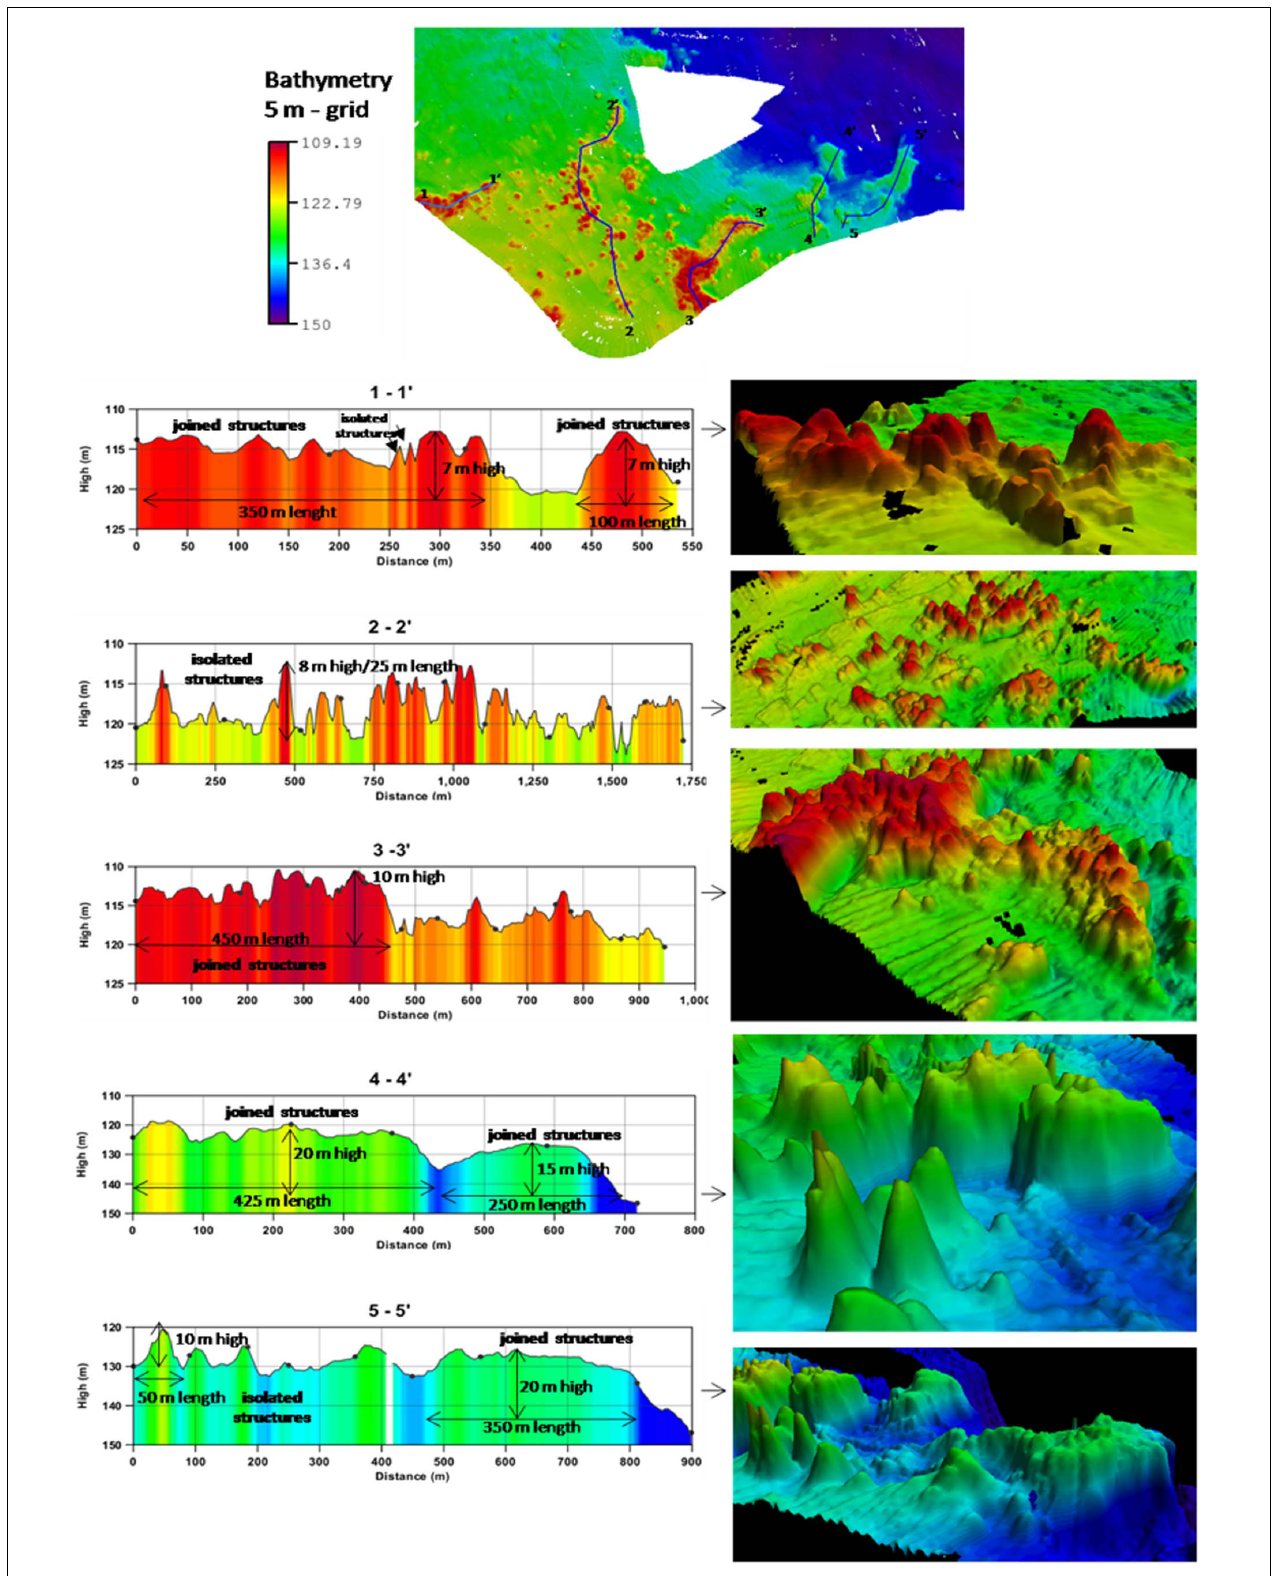
FIGURE 9 | Longitudinal profiles along the 5-m grid (from